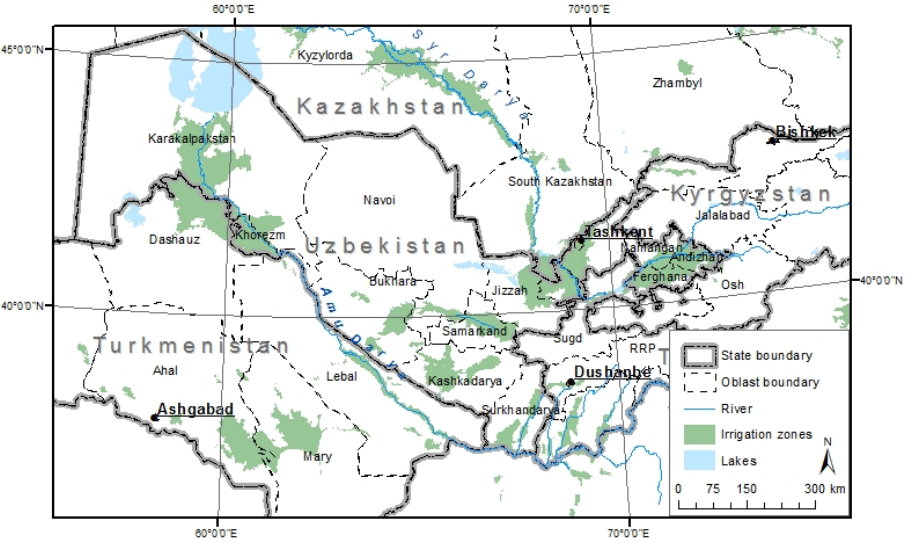
Figure 2. The location of rivers and irrigated areas in Central Asia. Source: GIS Lab of NGO KRASS at Urgench State University.